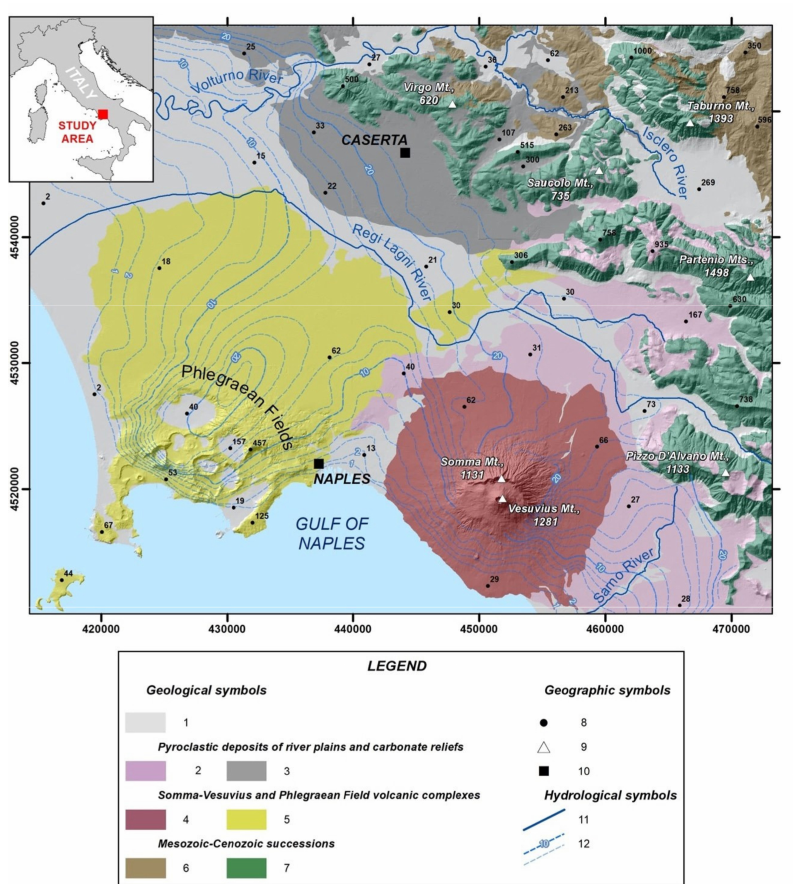
Figure 2. Western Campania region. Legend: (1) marine, lacustrine, fluvial, travertine and slope deposits (Quaternary); (2) volcanic deposits younger than 39 ka; (3) volcanic deposits older than 39 ka and Campanian Ignimbrite; (4) pyroclastites and lavas of the Somma-Vesuvious (39.3 ka- Recent); (5) pyroclastites and lavas of the Phlegraean Fields and Procida Island (76.8 ka-1538 AD); (6) Miocene-Pliocene deposits and flysch sequences; (7) dolostones and limestones (Jurassic- Cretaceous); (8) elevation point (elevation in m a.s.l.); (9) mountain peak (with elevation); (10) main city; (11) major river; (12) water table of the Campanian Plain (piezometric line spacing is 2